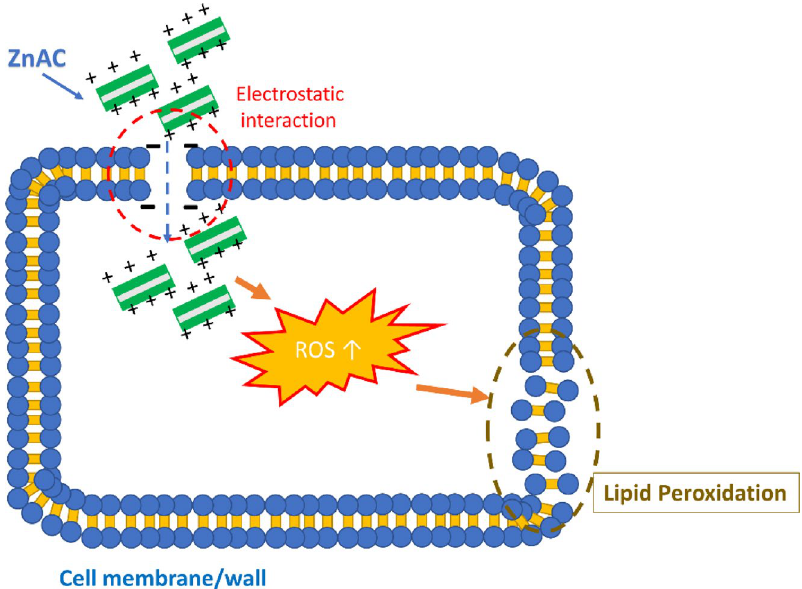
Figure 3. Antimicrobial mechanism of ZnAC. The image was drawn by Microsoft PowerPoint Version